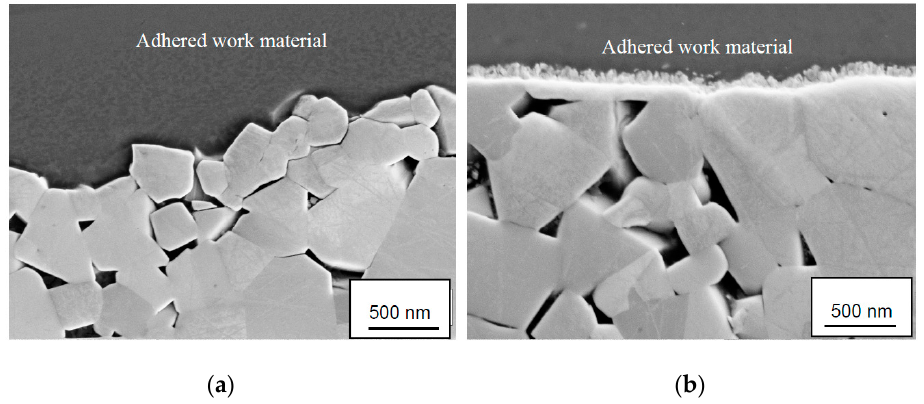
Figure 6. Cross-sections showing the worn cemented carbide in the center of the crater wear region. ( a ) Rough surface morphology due to attrition wear observed at low cutting speed and ( b ) smooth worn surface morphology due to diffusion wear observed at high cutting speed. Note the fine nanometer scale surface morphology of the diffusion layer in ( b ).